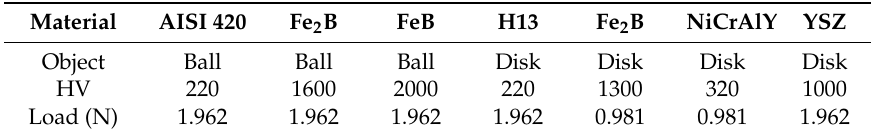
Table 2. Microhardness measurements, measured on the cross-section of the samples. Uncertainty is comprised between ~5% for the lowest hardness and ~15% for the highest hardness. Measurements were made on the ball and the disk with the highest number of layers (3rd and 5th on Table 1).